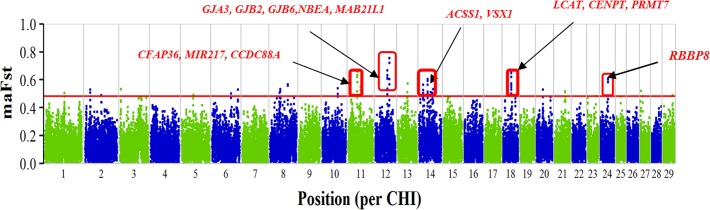
Plot of moving average FST-values of SNPs per chromosome. The plot shows comparison of Boer goats with other Ugandan goat breeds and candidate genes in putative selective signatures are shown in red. The horizontal red line (at 0.482) represents the 95%-percentile of raw FST-values.